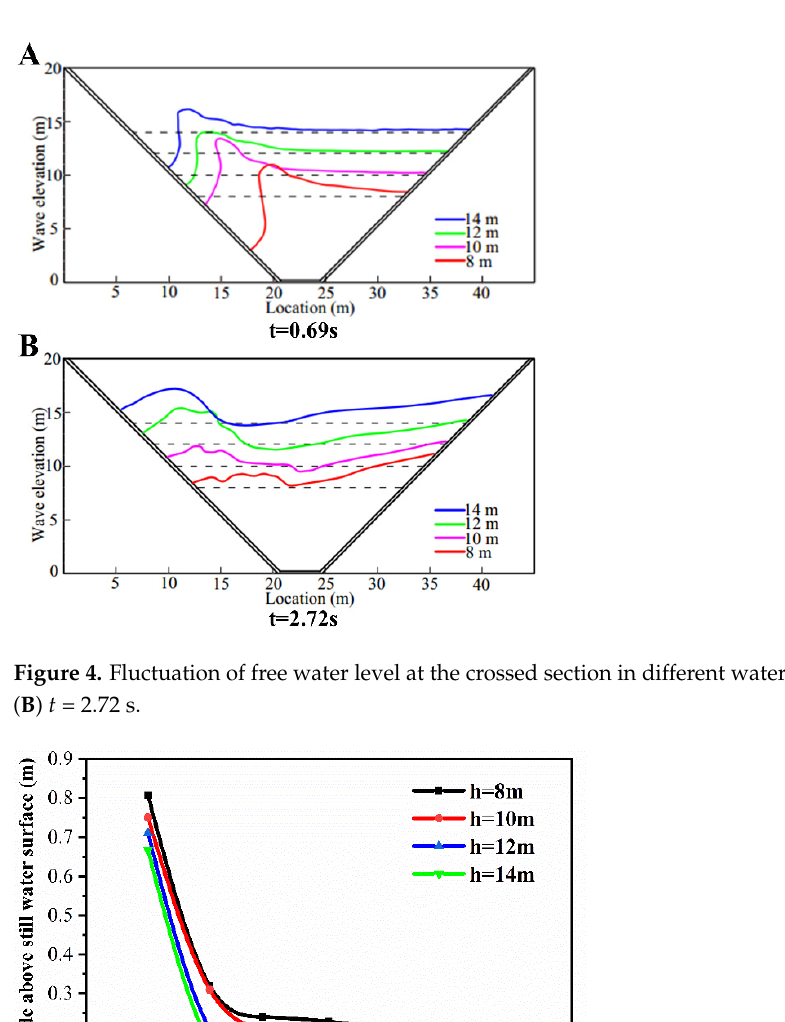
Figure 5. Variation of wave amplitude above still water level with propagation distance in different water depths.